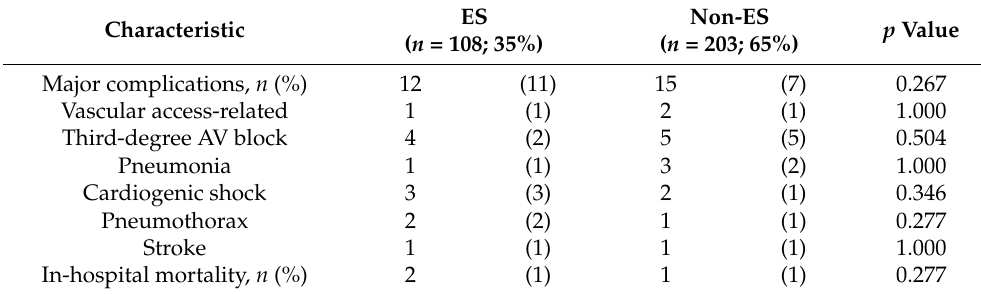
Figure 2. Prognostic impact of ES on VT recurrences ( left panel), rehospitalization rates ( middle panel) and cardiovascular mortality ( right panel).